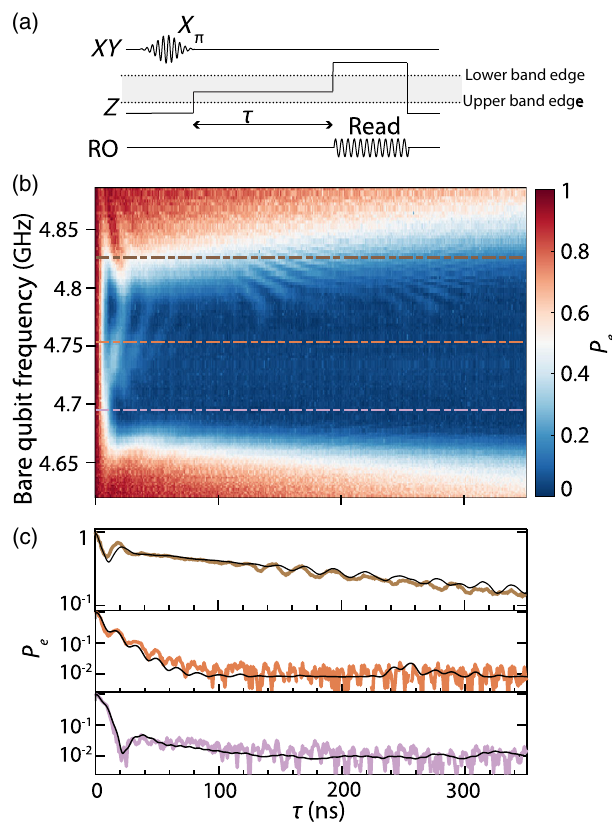
FIG. 3. Non-Markovian radiative dynamics in a structured photonic reservoir. (a) Pulse sequence for the time-resolved measurement protocol. The qubit is excited while its frequency is 250 MHz above the upper band edge, and then it is quickly tuned to the desired frequency ( ω 0 ) for a interaction time τ with ge the reservoir. After interaction, the qubit is quickly tuned below the lower band edge for dispersive readout. (b) Intensity plot showing the excited-state population of the qubit versus inter- action time with the metamaterial waveguide reservoir as a function of the bare qubit frequency. (c) Line cuts of the intensity plot shown in (b), where the color of the plotted curve matches the corresponding horizontal dot-dashed curve in the intensity plot. Solid black lines are numerical predictions of a model with experimentally fitted device parameters and an assumed 0.8% thermal qubit population (see Appendix E for further